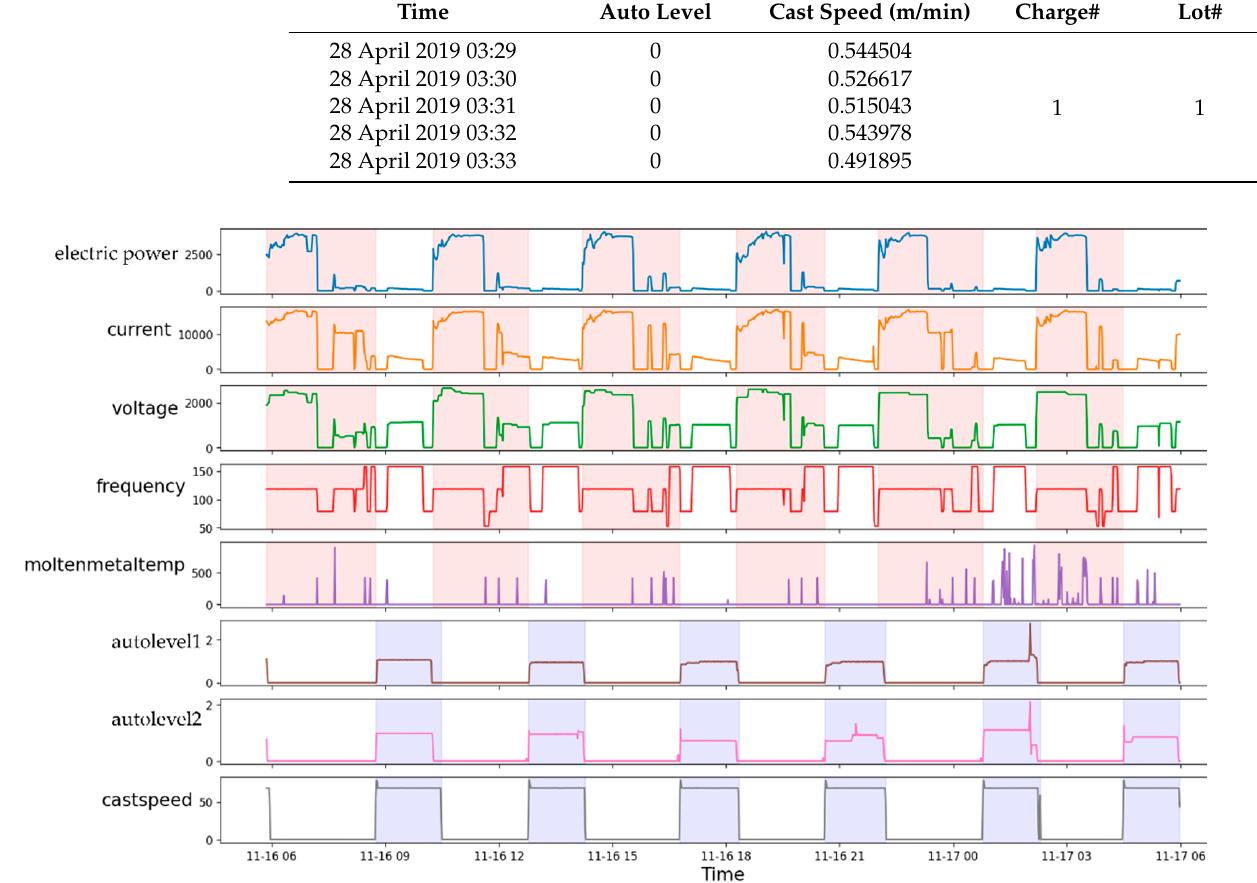
Figure 8. Extracting melting and casting TSWP from real-time data (pink areas indicate melting process, purple areas indicate casting process).